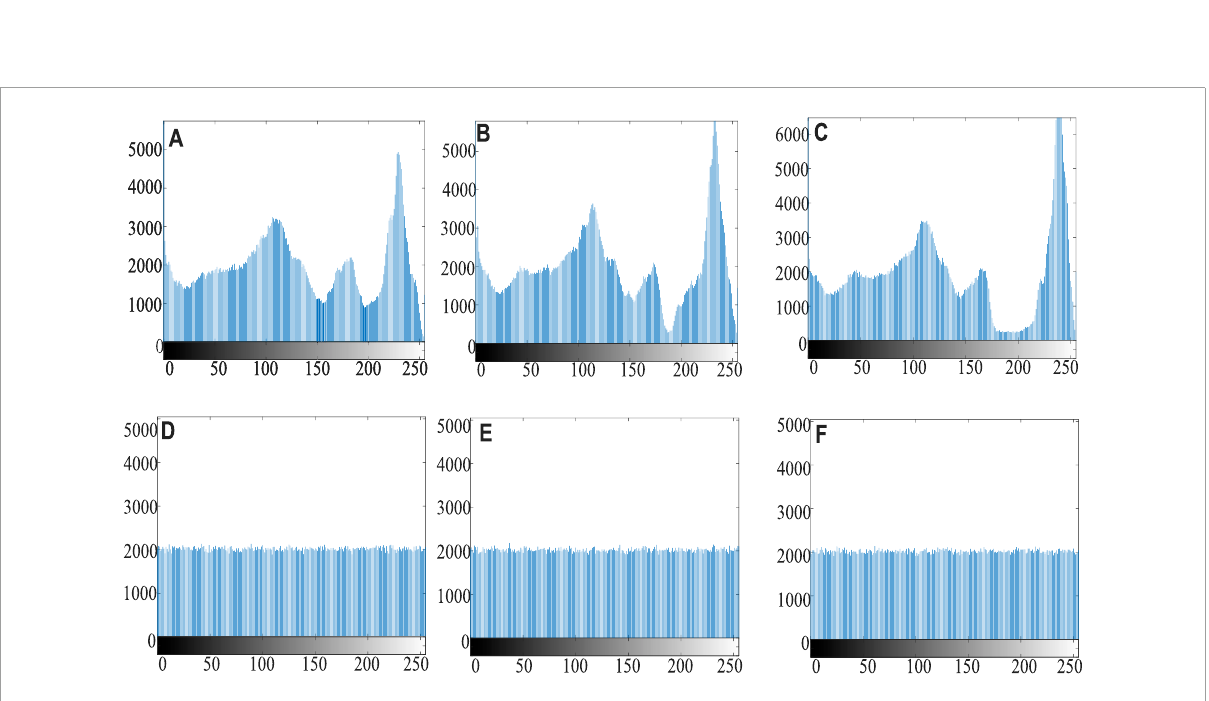
FIGURE 12 The histogram of the “picture 1”, (A) R channel in plain picture 1 (B) G channel in plain picture 1 (C) B channel in plain picture 1 (D) R channel in cipher picture 1 (E) G channel in cipher picture 1 (F) B channel in cipher picture